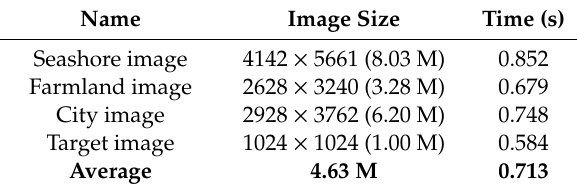
Table 3. Algorithm running